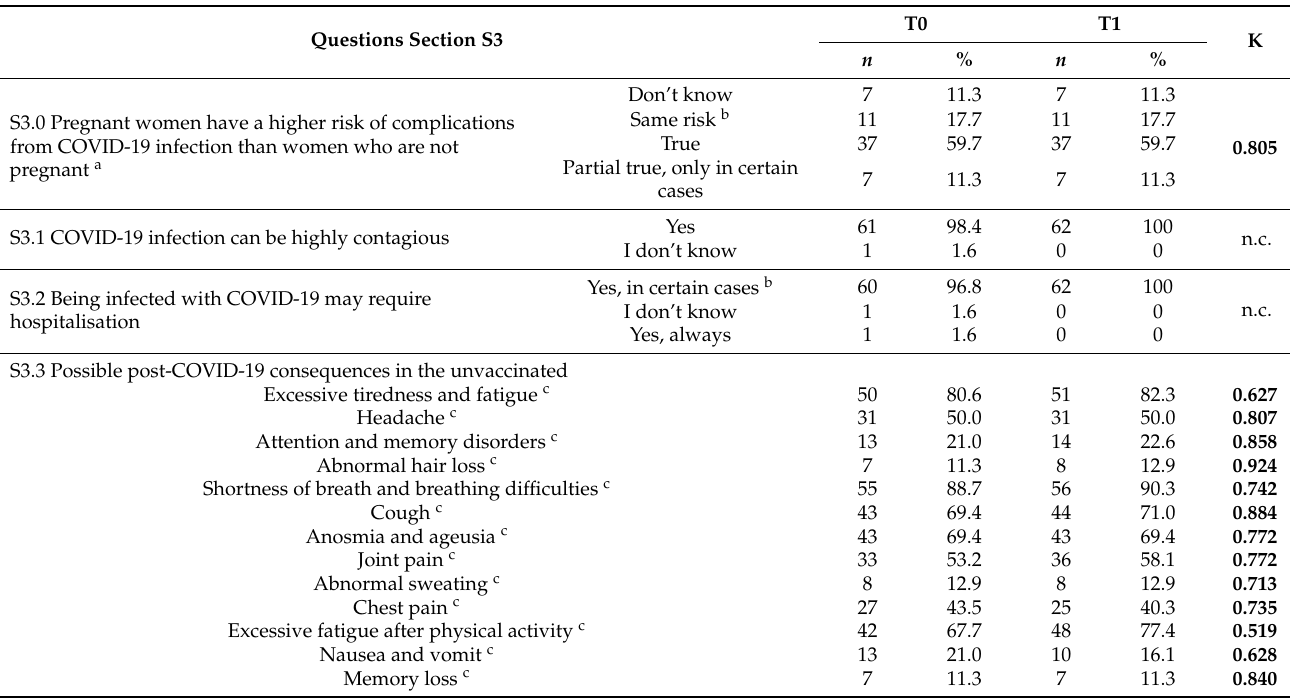
Table 4. Descriptive and reliability of “Section S3: Knowledge about effect of disease and possible post COVID-19 consequences in the unvaccinated” ( n =